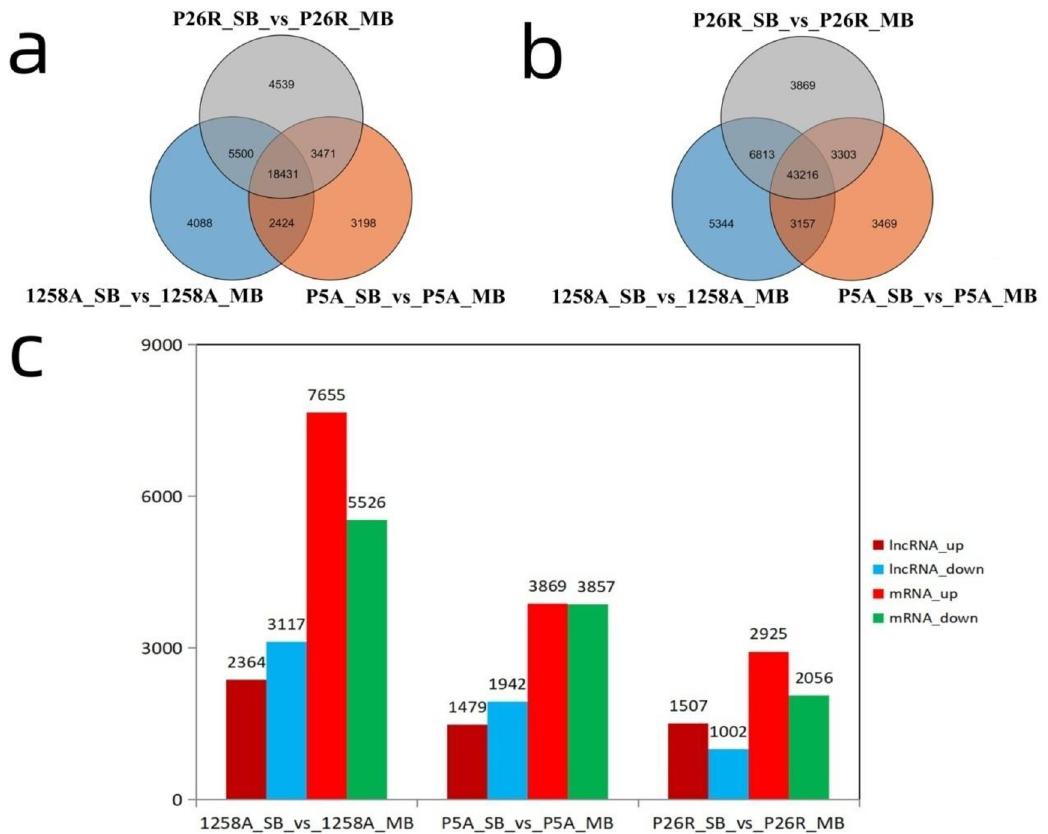
Fig 5. Statistical analysis of lncRNA and mRNA that were differentially expressed at different stages of pollen development. a: Venn diagram of differentially expressed lncRNA in different sizes buds of 1258A, P5A, and P26R. b: Venn diagram of differentially expressed mRNA in differently sized buds of 1258A, P5A, and P26R. c: Statistical results of up-regulated and down- regulated lncRNA and mRNA in different sizes buds of 1258A, P5A, and